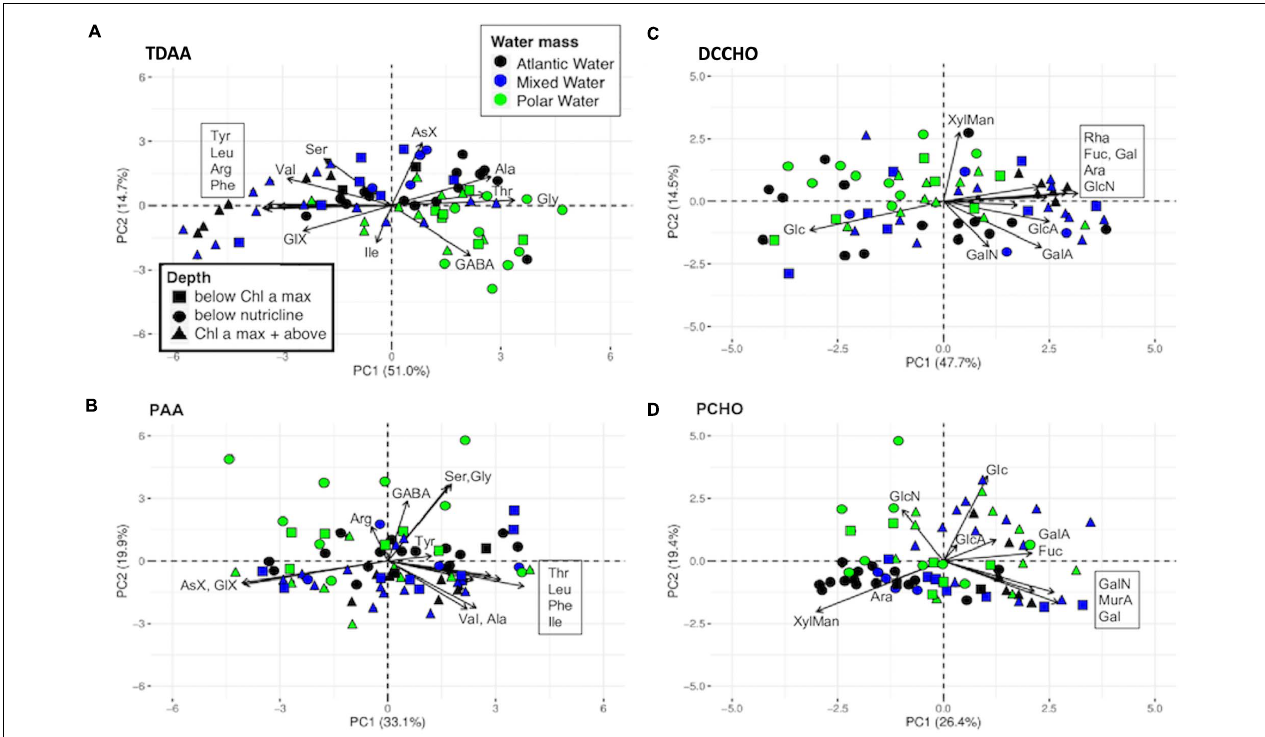
FIGURE 5 | PCA biplot of AA and CHO composition in dissolved (A,C) and particulate (B,D) fractions. Boxed abbreviations of AA and CHO in each panel refer to the respective cluster of arrows where direct association of arrow and molecule name was not graphically possible. Color and symbols refer to water mass and depth,